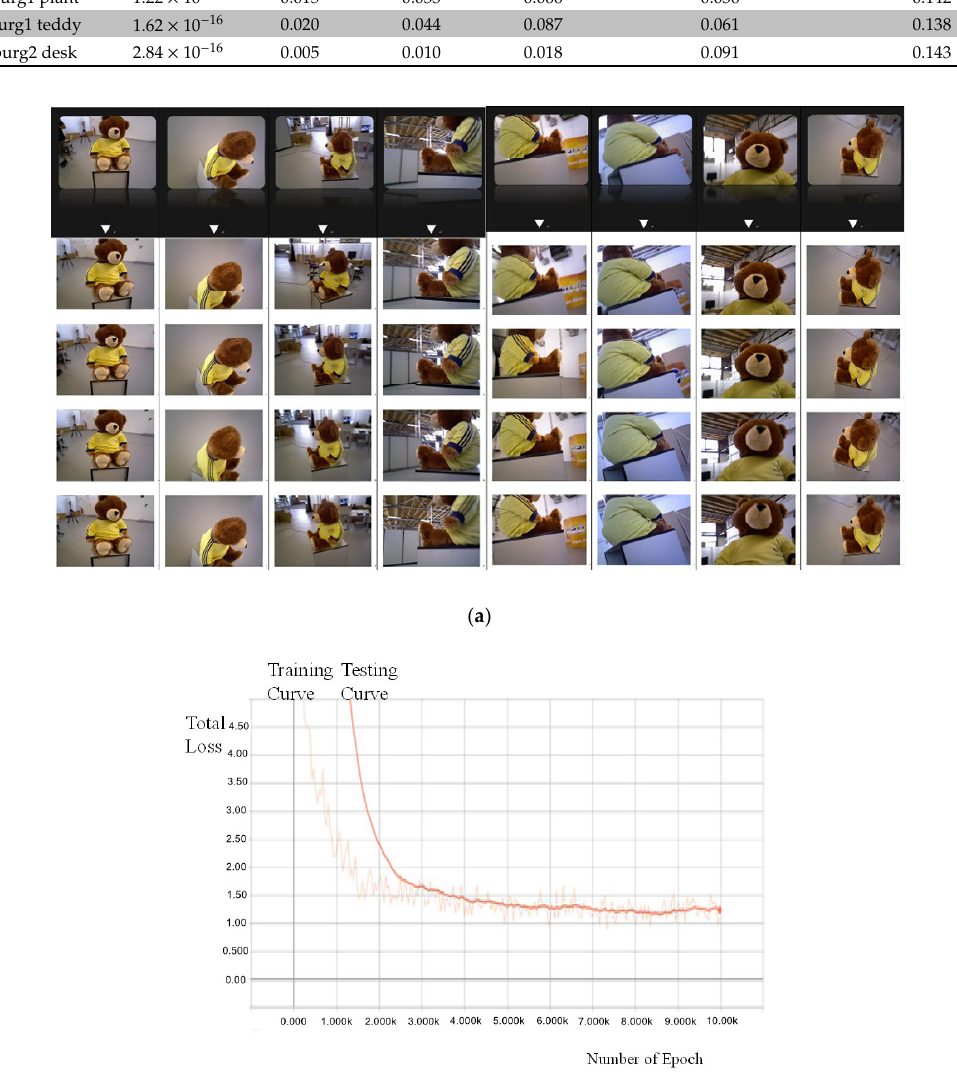
Figure 9. The view classification results using the dataset ‘freiburg3_teddy’: ( a ) example RGB templates of viewpoints and those of test images that are classified to individual viewpoint classes; ( b ) the training and testing learning curves of the proposed viewpoint classification neural network with cross-entropy as the loss